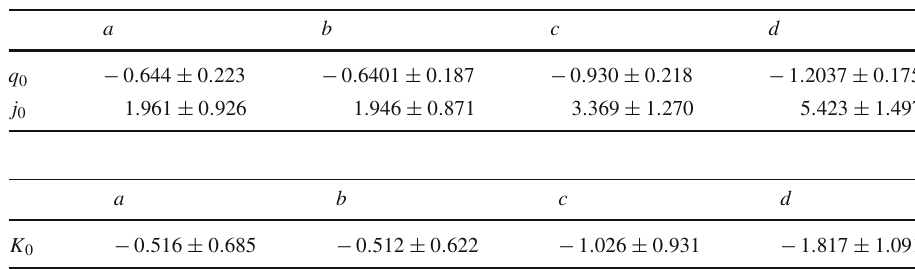
Table 2 Deceleration and jerk